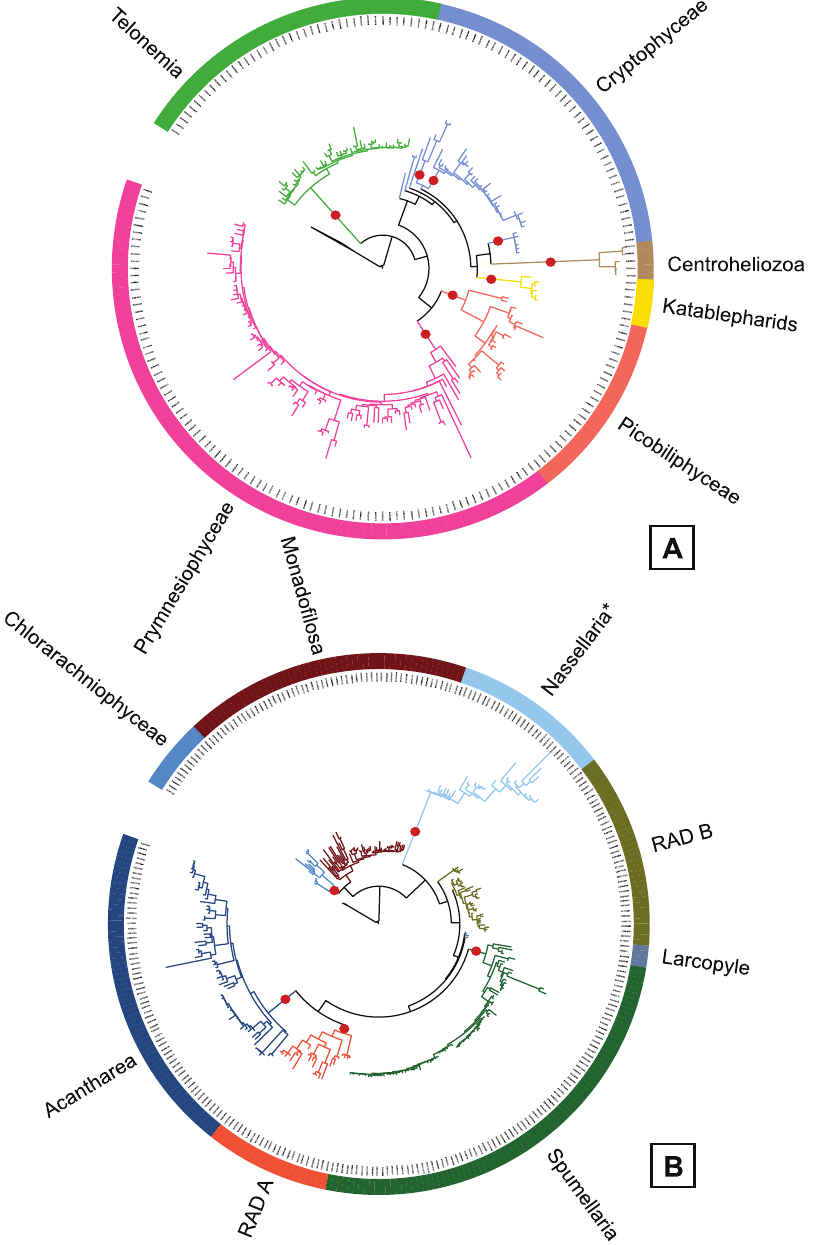
Figure 3. Maximum Likelihood phylogenetic trees for eukaryotic supergroups. Trees include several taxonomic groups within CCTH (A), and Rhizaria (B) and are done with sequences representative of each OTU obtained clustering at 0.05 distance. The number of sequences (about 550 bp in length) per tree 218 and 303 respectively. Red dots represent bootstrap values above 75.